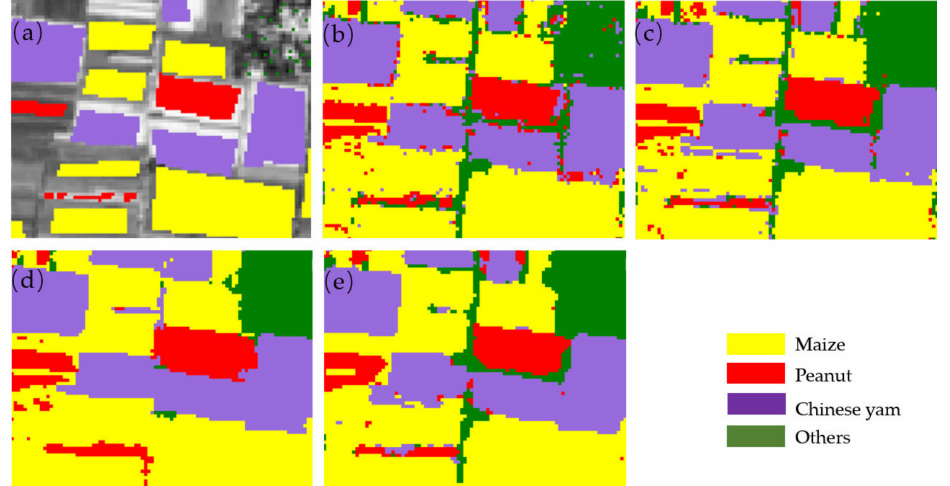
Figure 8. Comparison of different predicted results and partial testing set labels: ( a ) Partial testing set la-bels; ( b ) Single-temporal Sentinel-2 data; ( c ) Multi-temporal Sentinel-2 data; ( d ) Multi-temporal Sentinel-1 data; ( e ) Fusion of multi-temporal Sentinel-1 and -2